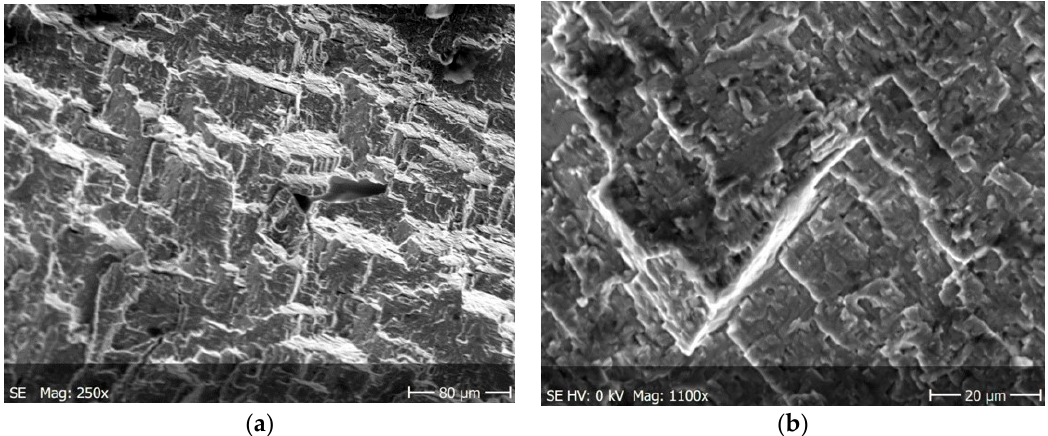
Figure 14. Fractures in the tested material after fatigue tests for; ( a ) a larger specimen area, ( b ) enlarged